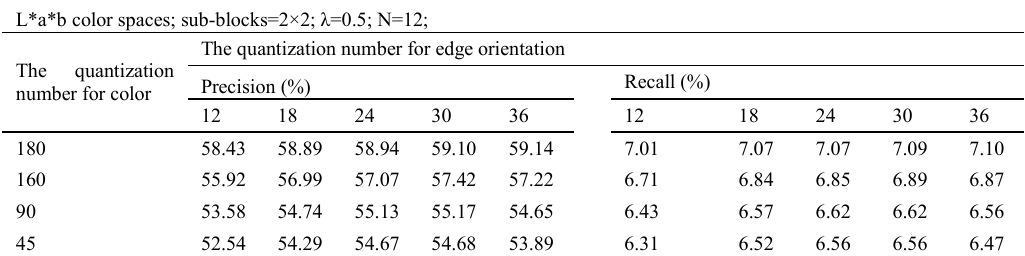
Table 3. Average retrieval precision and recall in the L*a*b color space